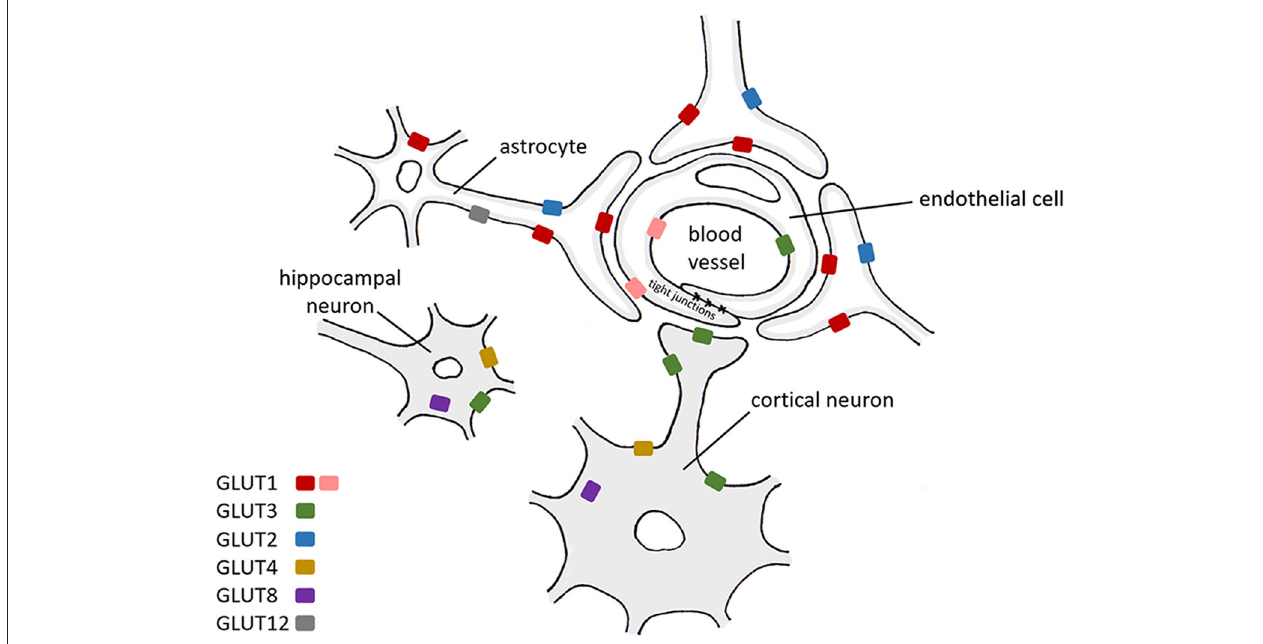
FIGURE 1 | A schematic diagram representing the expression of glucose transporters within CNS cells. Red: GLUT1 55 kDa isoform, pink: GLUT1 45 kDa isoform. GLUT1 (Kumari and Heese, 2010), GLUT2 (Kumari and Heese, 2010), GLUT3 (Kumari and Heese, 2010), GLUT4 (Leloup et al., 1996; Vannucci et al., 1998; Reagan, 2002; Kumari and Heese, 2010 ), GLUT8 (Kumari and Heese, 2010), GLUT12 (Zhang et al., 2014) (details extracted from https://www.brainrnaseq.org on